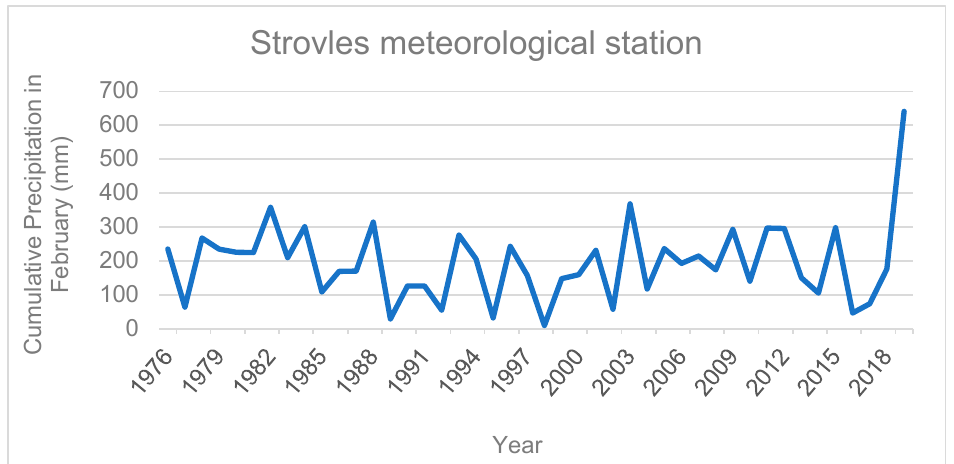
Figure 5. Cumulative precipitation in February from 1976 to 2019 at the Strovles meteorological station.